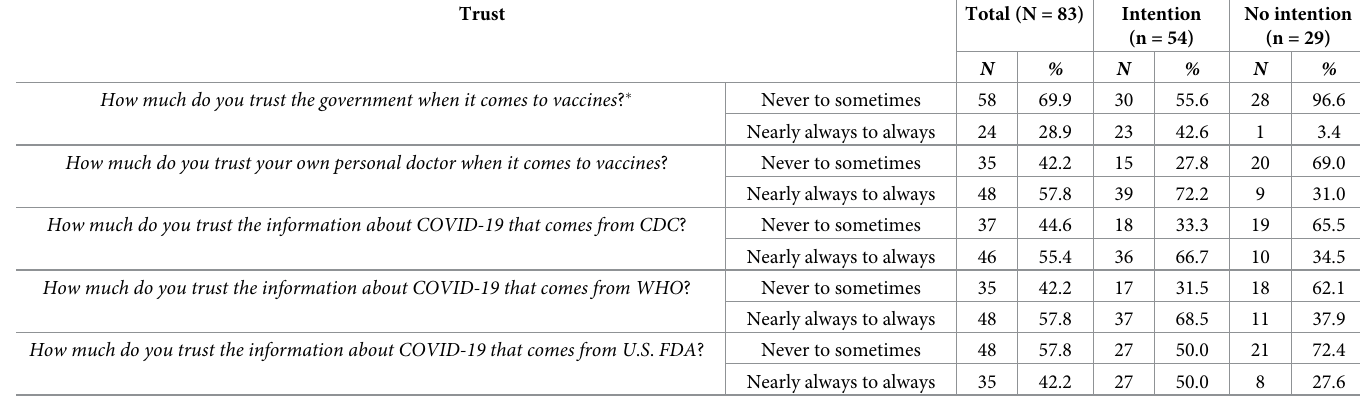
Table 3. Trust in government and medical authorities, total and by intentions to get a COVID-19 vaccine (N = 83).